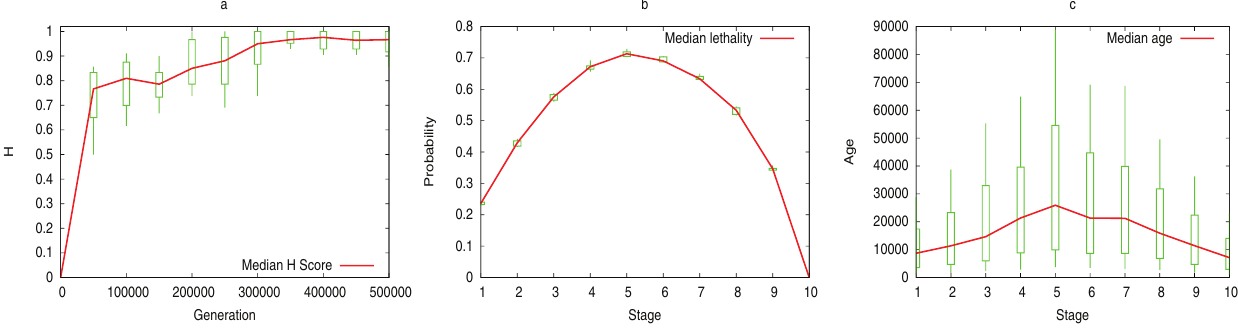
Figure 6. Computational results with Model-2. Parameters: 10 runs with different initial populations, N = 1000 individuals, L = 10 stages, specificity function s ( l ) = l / L ( l = 1 . . . L − 1), Γ = 100 genes at each stage initially, RF parameter z = 4, 500,000 generations, probability of RW event P = 10 −4 . The red line is the median and the green boxes are the 10th, 25th, 75th, and 90th percentiles, across all individuals RW and all runs. ( A ) The hourglass score H across evolutionary time. ( B ) Lethality probability at each stage. ( C ) Age of existing genes at the last generation.